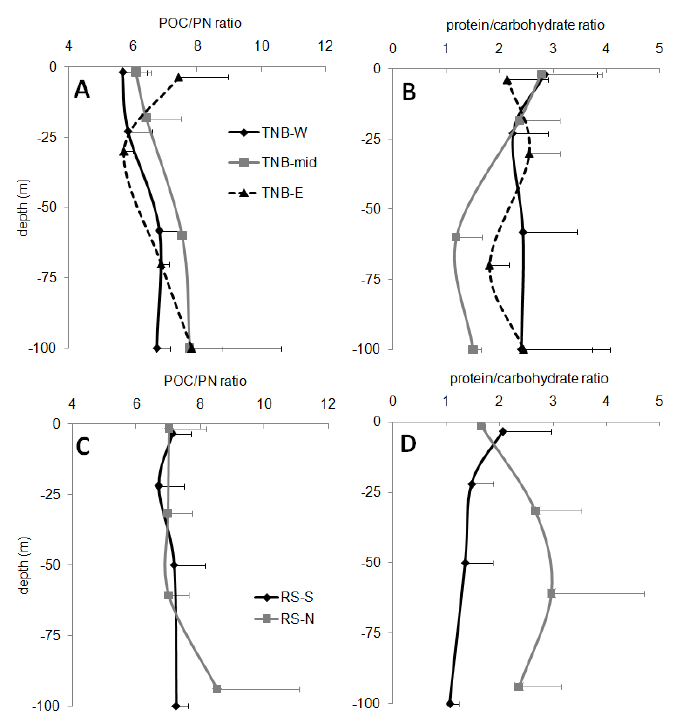
Figure 4. POM related ratios as POC/PN ratio and protein/carbohydrate ratio in the coastal TNB macro-area (upper panels A , B ) and in the RS offshore macro-area (lower panels C , D ).